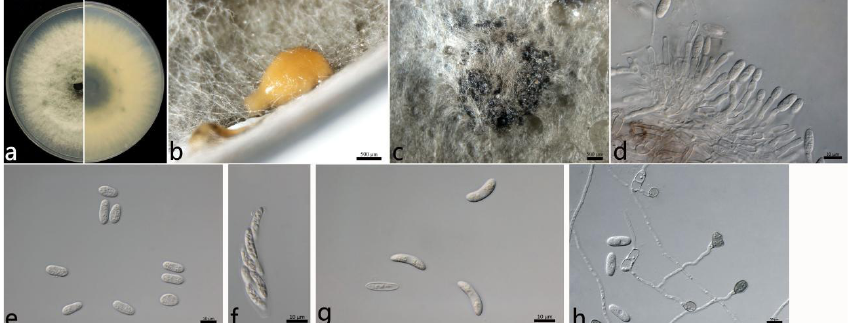
Figure 4. The morphological characteristics of Colletotrichum fructicola (SD1-6) isolated from anthrac- nose leaves of Salix babylonica . ( a ) Colony on PDA from above and below (5 d). ( b ) Conidial mass (on PDA). ( c ) Ascomata (on PDA). ( d ) Conidiophores, conidiogenous cells, and conidia. ( e ) Conidia. ( f ) Ascus. ( g ) Ascospores. ( h ) Conidia and appressoria. Scale bars: ( b , c ) = 500 µm; ( d – h ) = 10 µm. 2.3.3. Colletotrichum gloeosporioides s.s. (Penz.) Penz. and Sacc (Figure 5) The colonies on the PDA were white to grayish white at the center; in contrast, the center was dark green, and the margin was white. The aerial mycelium was white, dense, and cottony with a growth rate of 14.2 mm/d. Orange conidial masses were often observed in the center of the colonies. The acervuli were orange, elliptic, numerous, and pale to dark grey at the base. The conidiophores were hyaline to pale brown, smooth, septate, and rarely branched. The conidiogenous cells were cylindrical to flask-shaped, hyaline, taper-